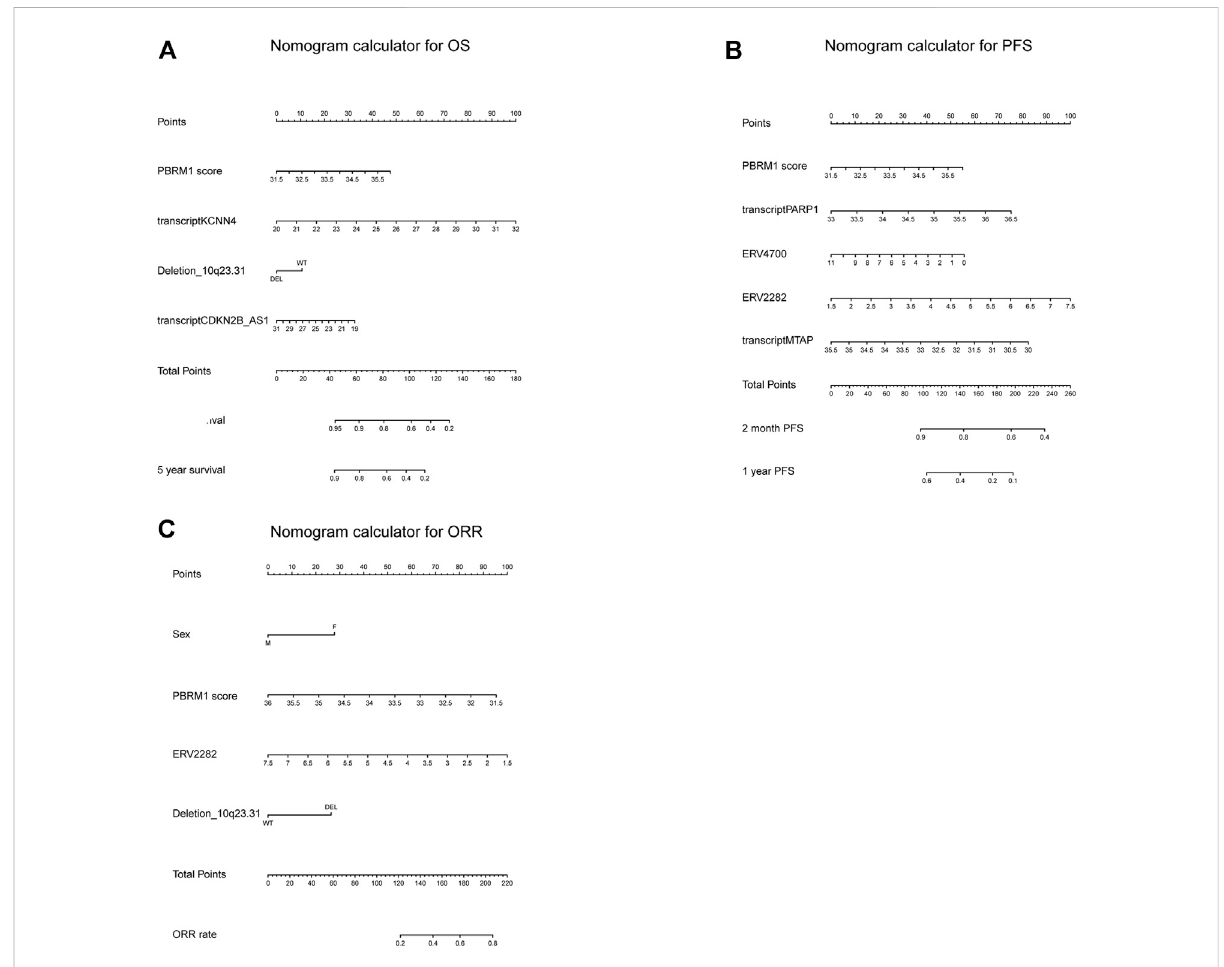
The nomogram calculator for OS, PFS, and ORR. (A – C) The nomogram calculator for OS (A) , PFS (B) , and ORR (C)